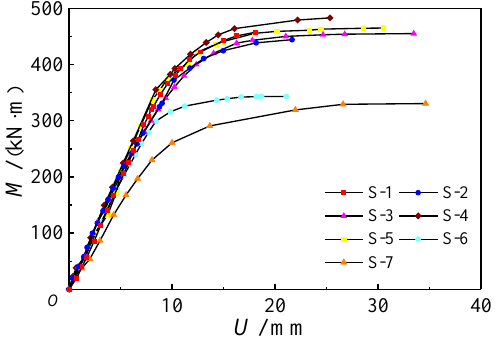
Table 4. Moment capacities and the corresponding deflection.